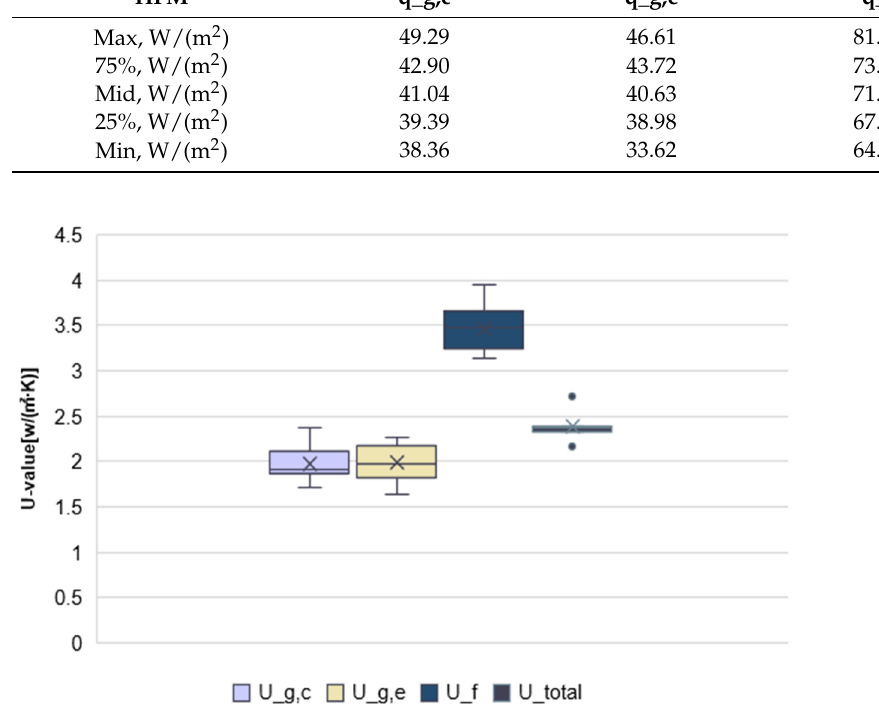
Figure 6. Boxplot of U-value results using the HFM method. Table 6. Window U-value using the HFM